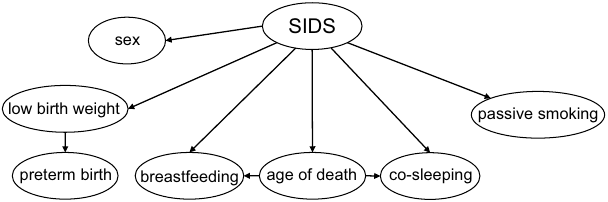
Figure 4. A Bayesian onset-predictive support model for SIDS. A conditional probability table was incorporated for each factor. Including the presence or absence of each factor produces a SIDS-onset probability as an annual incidence rate per 1000 of the population. The prior probability of annual SIDS incidence in the general population was 0.3/1000 live births calculated from vital statistics of a population survey 9,18 and our 64 cases. SIDS, sudden infant death syndrome.